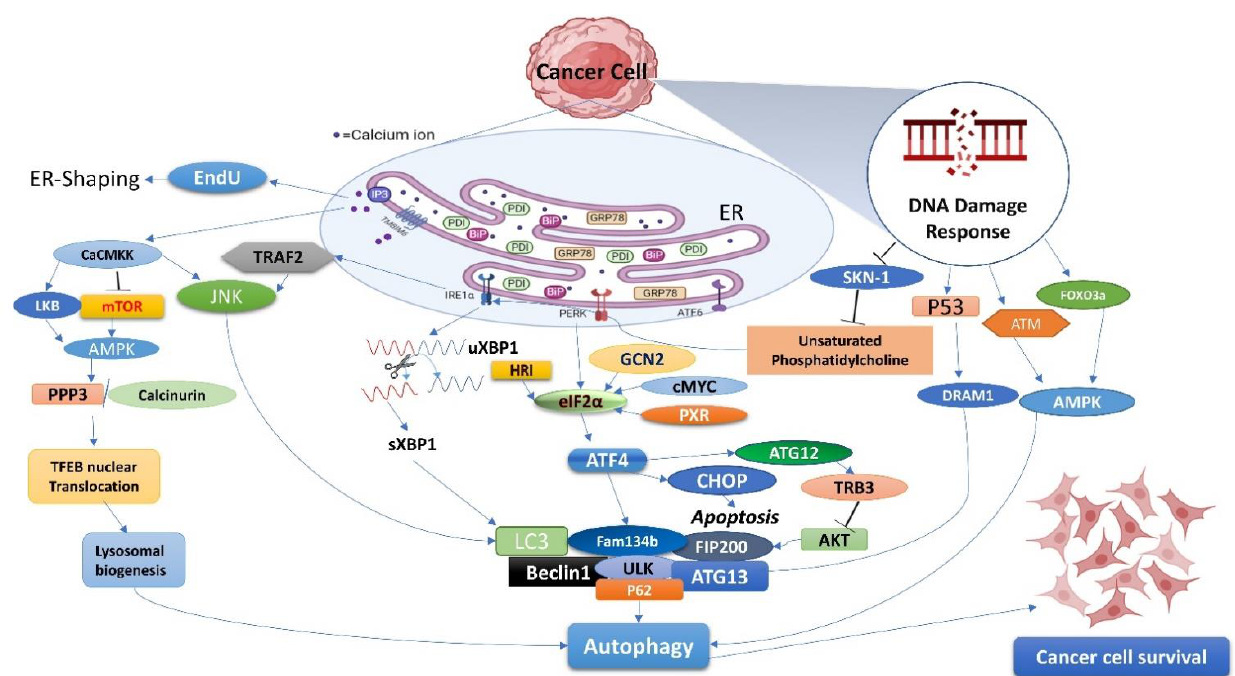
Figure 2. Graphical representations of molecular pathways that contribute to cell survival during stress conditions suggest potential cancer therapeutic targets. ER stress in cancer cells is triggered by multiple factors, effectively inducing autophagy. Canonical pathway is linked to a common UPR pathway involving IRE1 α , PERK, and ATF6. Here, the pathway regulates the LC3, Beclin 1, and P62 ATG proteins and shows enhanced cell viability. Contrastingly, the noncanonical pathway involves Ca 2+ , ER-phagy, DNA damage response, and ISR-mediated autophagy. Under stress conditions, Ca 2+ release from ER by Ca 2+ channel and TMBIM6 activates EndoU for ER-shaping and CaCMKK- mediated autophagy by activation of JNK and AMPK. AMPK regulates PPP3/calcineurin, stimulating TFEB (transcription factor EB) nuclear translocation and influencing lysosomal biogenesis. Separately, the DDR-autophagy axis is one of the most intriguing functional consequences of preventing radiation or chemotherapy-induced cell death by repairing DNA damage. DNA damage response inhibited SKN-1 and activated IRE1 α , FOXO3a, ATM, and P53-mediated autophagy, enhancing cell survival rate. In addition, ISR promotes cellular survival signaling by negatively regulating cell death pathways through the phosphorylation of eIF2 α by GCN2, HRI, and cMYC. The eIF2 α and ATF4 are common features of autophagy activation.